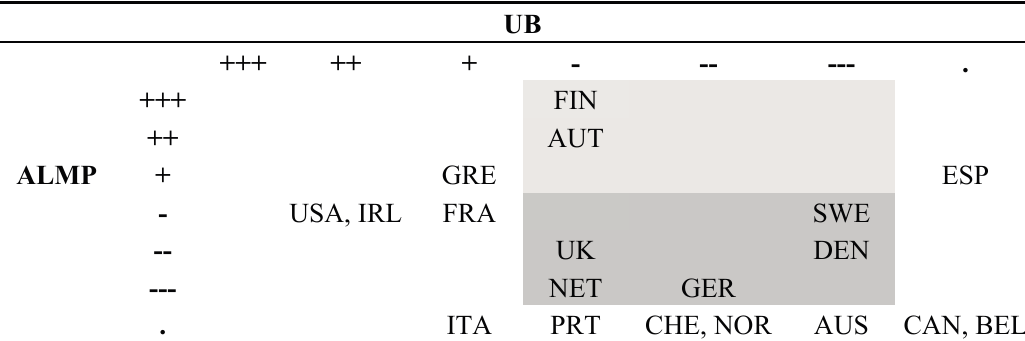
Table 5. Active labor market policy expenditure (ALMP), unemployment benefit expenditure (UB) from the perspective of capital flow in 19 Western democracies according to the data